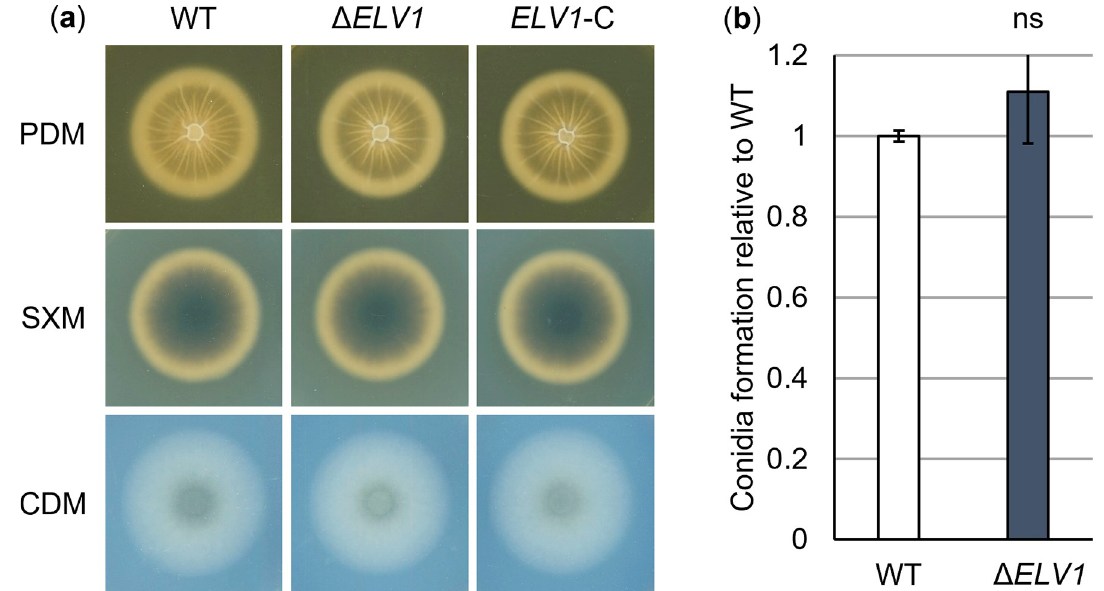
Fig 3. The Egh16 homolog-encoding gene ELV1 of Verticillium dahliae is dispensable for vegetative growth and conidiospore formation. The V . dahliae ELV1 deletion strain ( Δ ELV1 ) was compared with the JR2 wild-type (WT) in terms of morphology on plate and conidia formation. (a) 50,000 spores of respective strains were point-inoculated onto plates containing simulated xylem medium (SXM), potato dextrose medium (PDM) or Czapek-Dox medium (CDM) and incubated at 25˚C for 10 days. Bottom view scans depict a similar phenotype of Δ ELV1 compared with the wild-type and complementation strain ( ELV1 -C) on all media tested. (b) Conidia formation was quantified in five-day-old cultures in liquid SXM incubated at 25˚C with constant agitation after inoculation of 4,000 spores ml -1 . Error bars represent the SD of the means of two independent experiments, each with two biological and four technical replicates ( n = 4). No difference in the ability to form conidiospores was detected between Δ ELV1 and the wild-type (ns, not significant; calculated using t